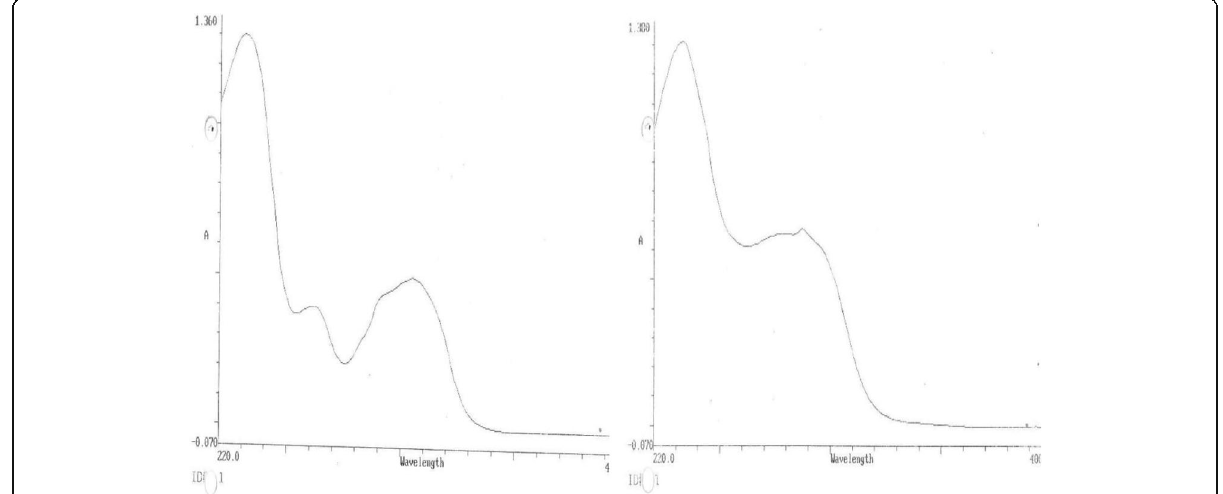
Fig. 2 UV absorption spectra for albendazole and mebendazole respectively in 0.1 M methanolic